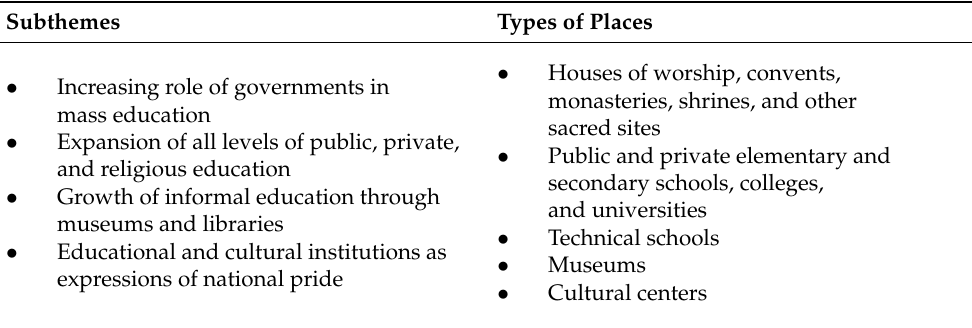
Table 6. Religious, Educational, and Cultural